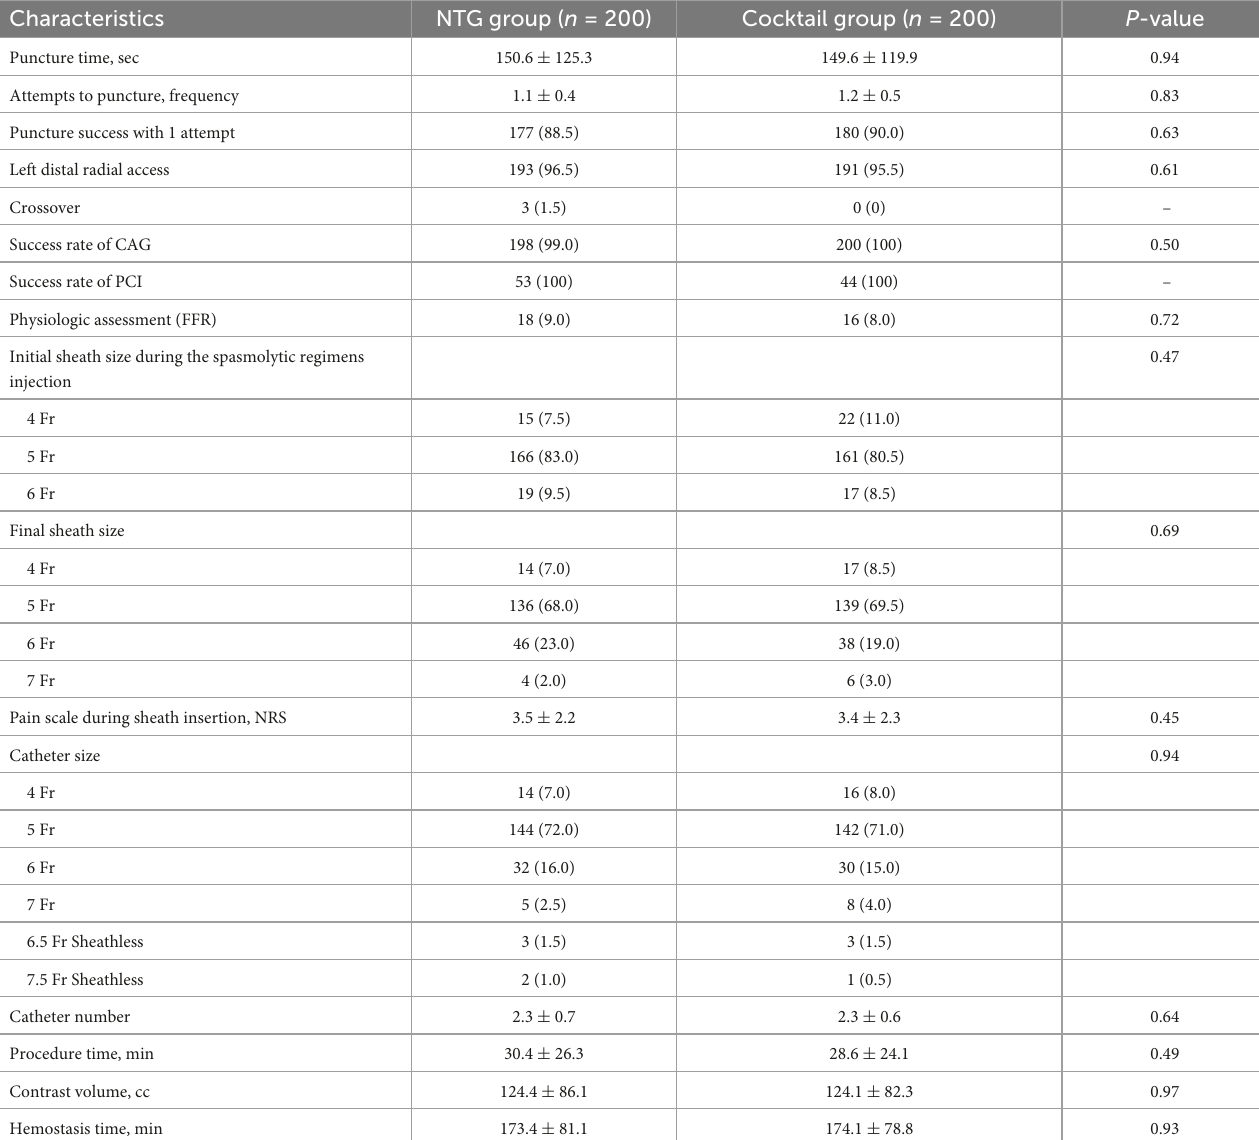
TABLE 2 Angiographic and procedural